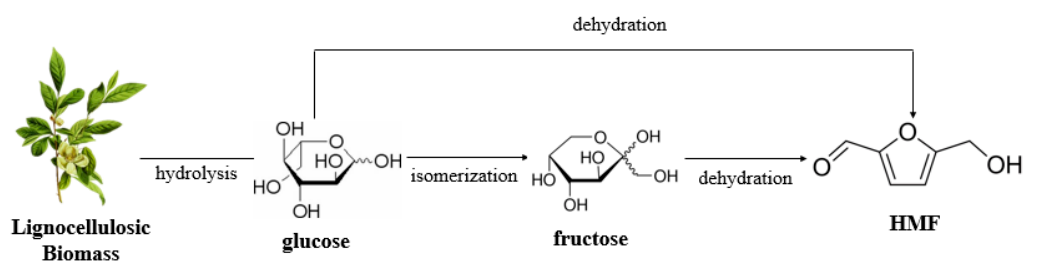
Figure 4. Production of HMF from lignocellulosic biomass.